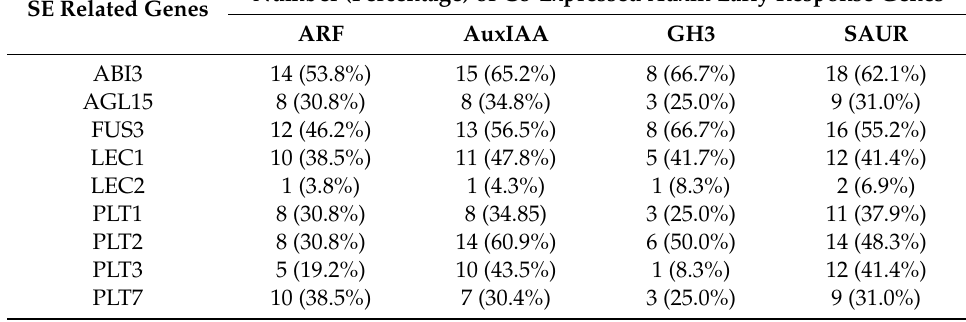
Statistics of the numbers of auxin early response genes co-expressed with somatic embryogenesis related